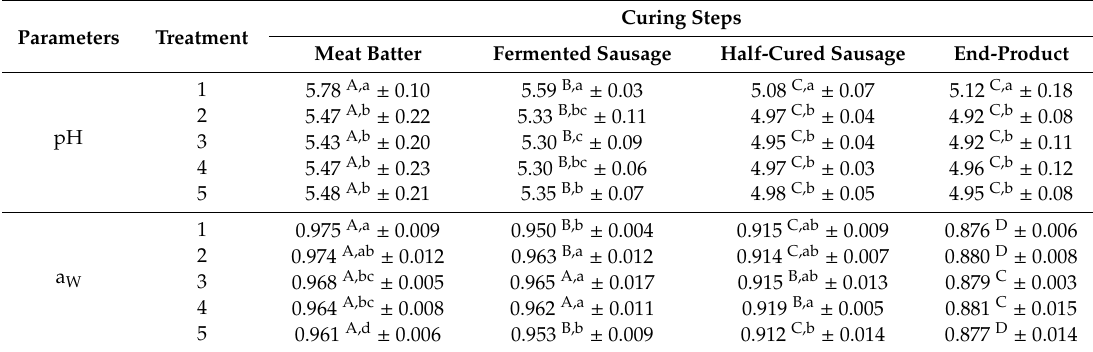
Table 1. E ff ect of starter cultures on the pH and a W of smoked fermented sausages.